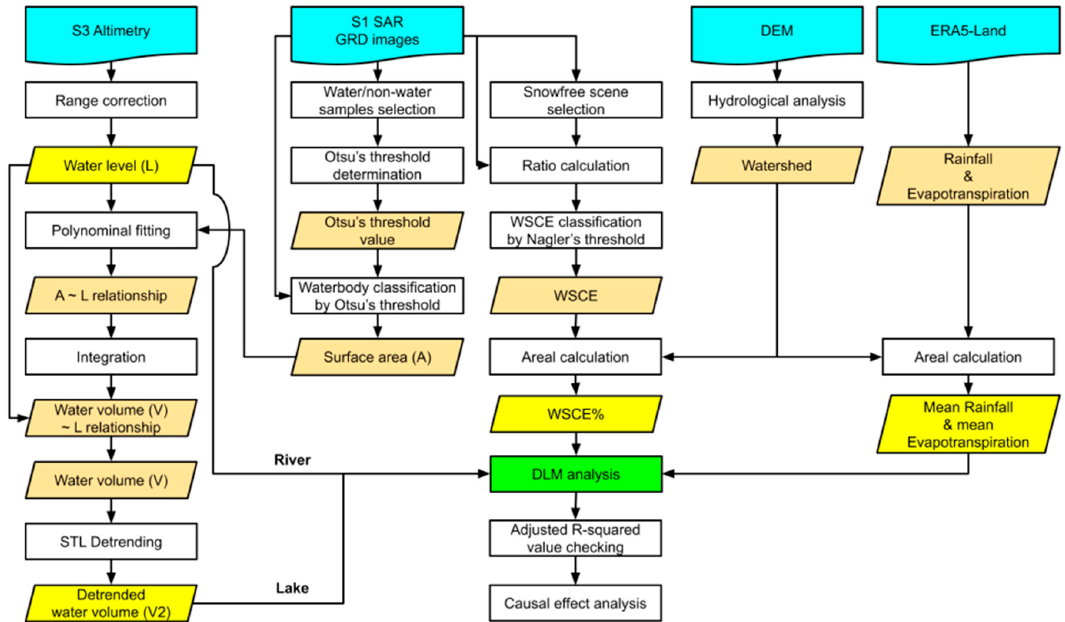
Figure 2. The overall workflow of the present study, including the processing of the Sentinel-1 synthetic aperture radar (SAR) and Sentinel-3 altimetry data for deriving the wet snow-covered extent (WSCE), surface area, and water level. The water volume estimated from polynomial fitting and integration is detrended by the Seasonal-trend decomposition procedures based on Loess (STL). Together with the hydrological factors derived from the ERA5-Land dataset, the distributed lag model (DLM) is eventually conducted. GRD: Ground Range Detected. The digital elevation model is abbreviated as DEM.